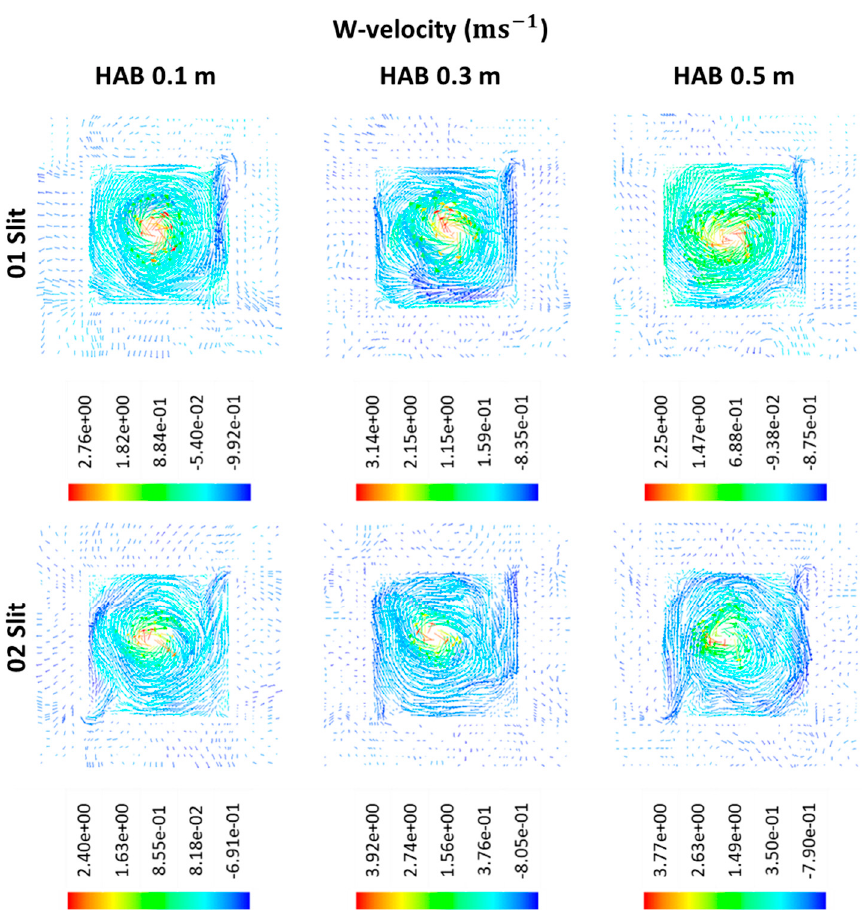
Figure 11. Plot of vector field of W-velocity of the two cases, at all monitoring HABs.